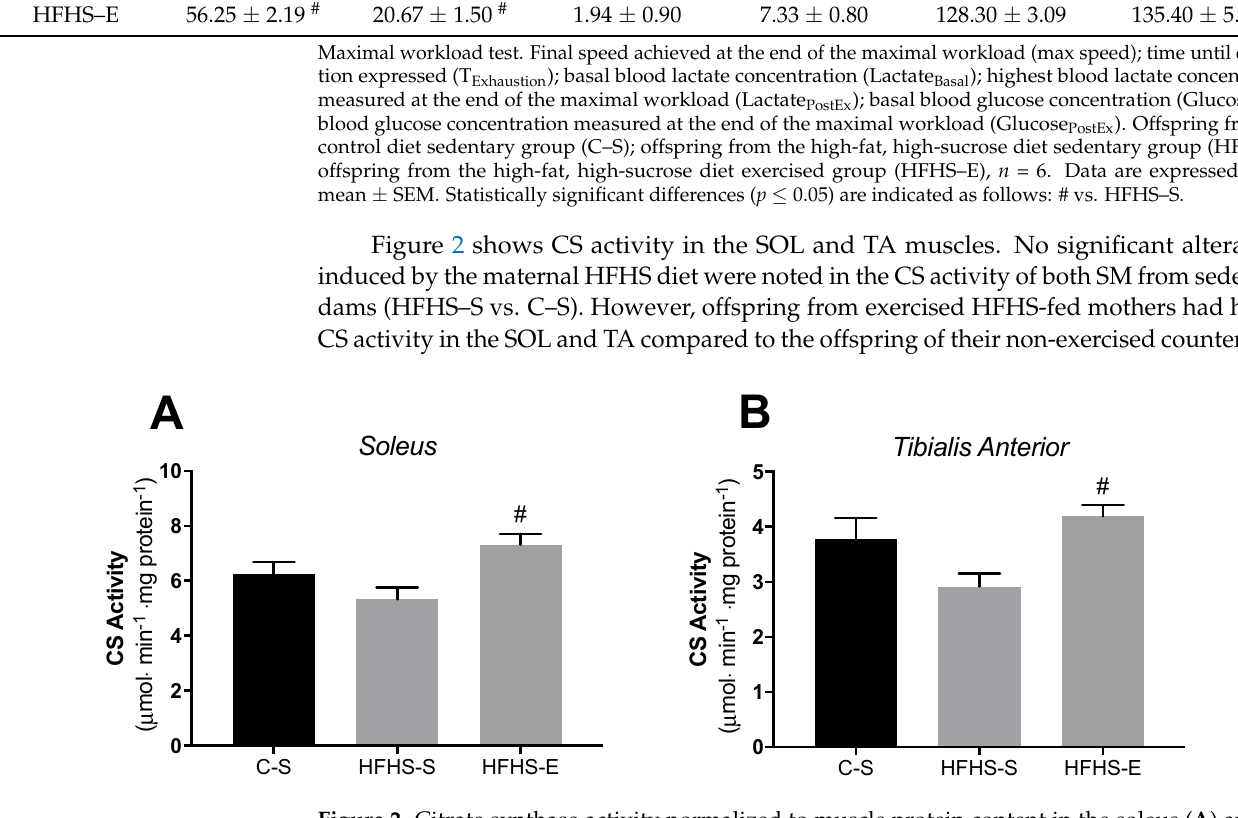
Table 2. Maximal workload test .